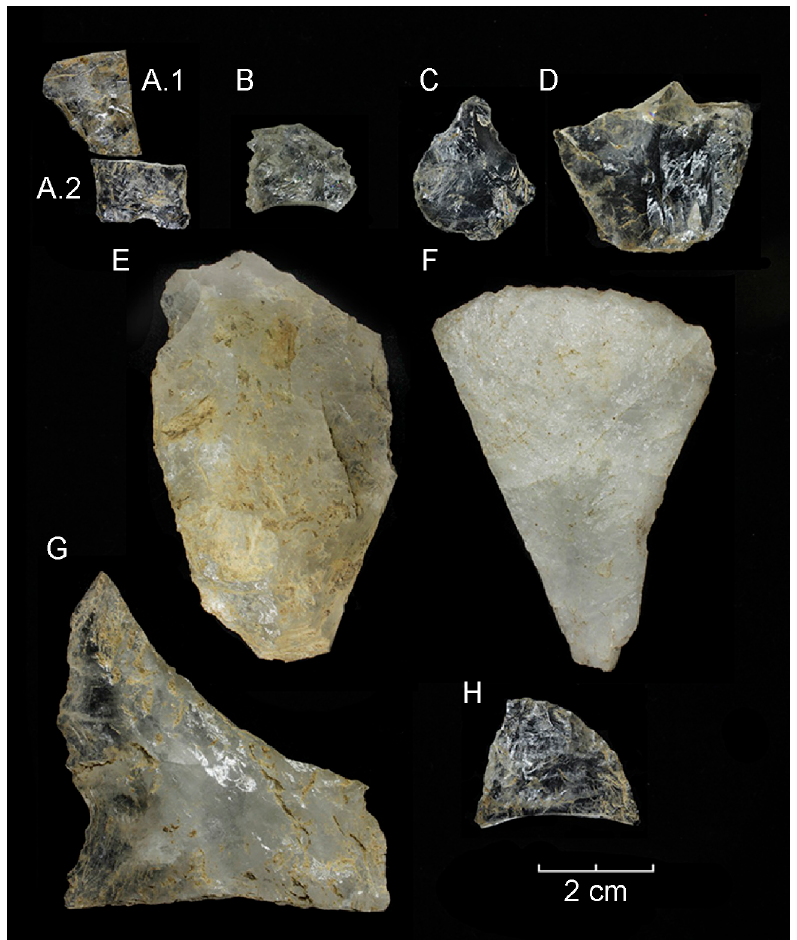
Fig 8. Selected quartz artifacts from Valiente. A.1. fishtail -type point preform mid-section (#304, unit A2, 52–62 cm), A.2. fishtail-type point preform stem (#305, unit A1, 52–62 cm), B. point fragment, mid-section (#RPA, exposed profile), C. lithic awl (#931, unit E2, 22–32 cm), D. bifacial blank (#184, unit A2, 42–52 cm), E. bifacial blank (#262, unit A2, 52–62 cm), F. scraper (#1080, unit E2, 22–32 cm), G. notched flake (#2528, unit B3, 42–52 cm), H. bimarginal cutting tool (#1775, unit C2, 42–52